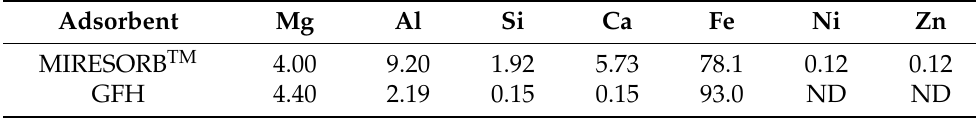
Table 1. Elemental compositions estimated by X-ray fluorescence